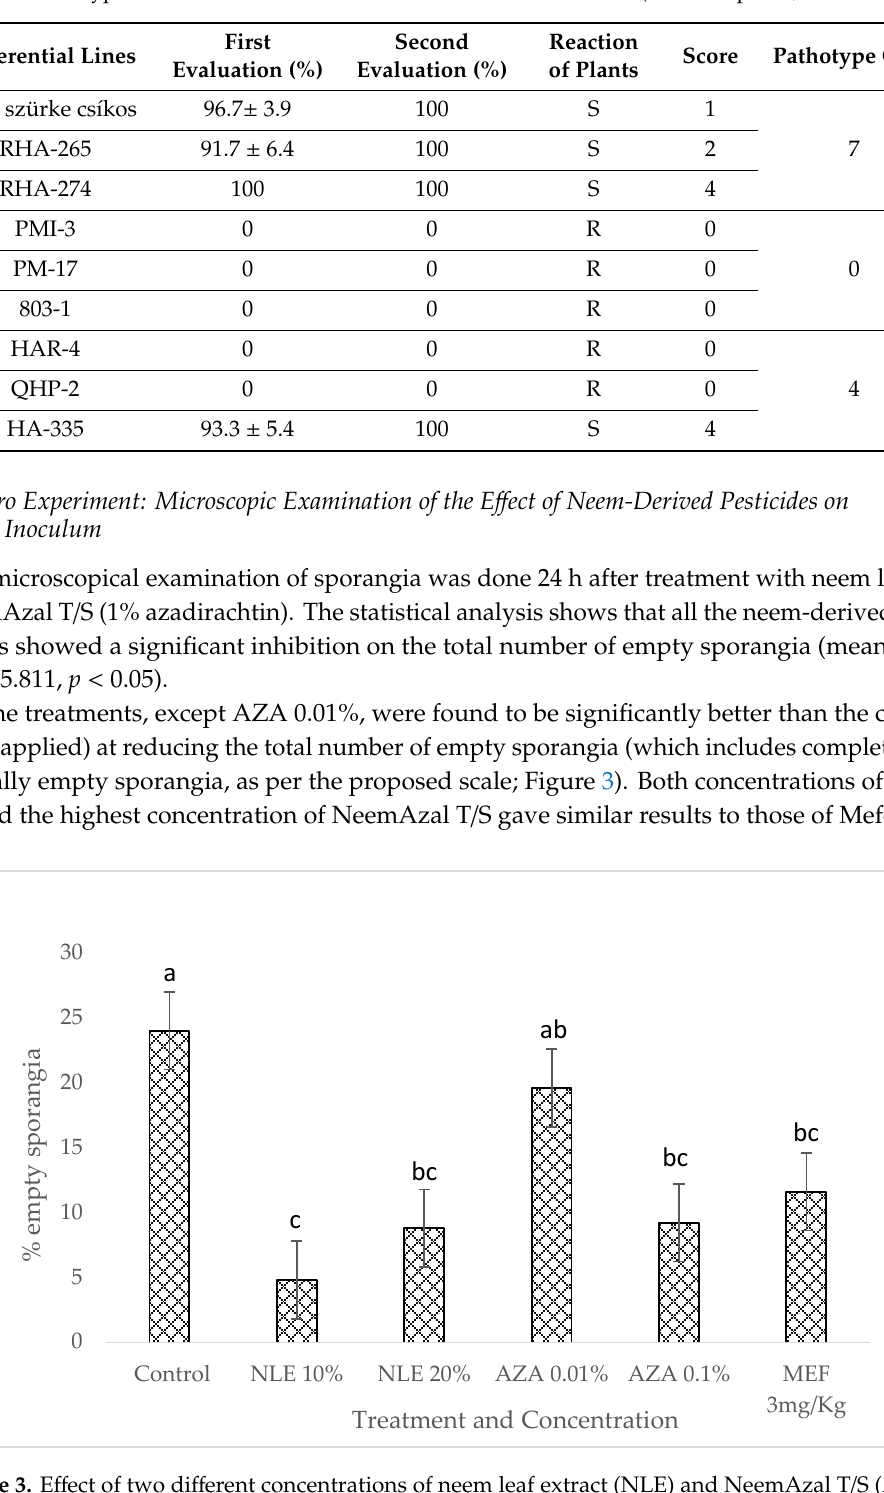
Figure 3. Effect of two different concentrations of neem leaf extract (NLE) and NeemAzal T/S (AZA), respectively, on the germination of P. halstedii sporangia. Mefenoxam (MEF) was used as a positive control). Different letters according to Tukey’s test indicate significant difference at 95% confidence level.